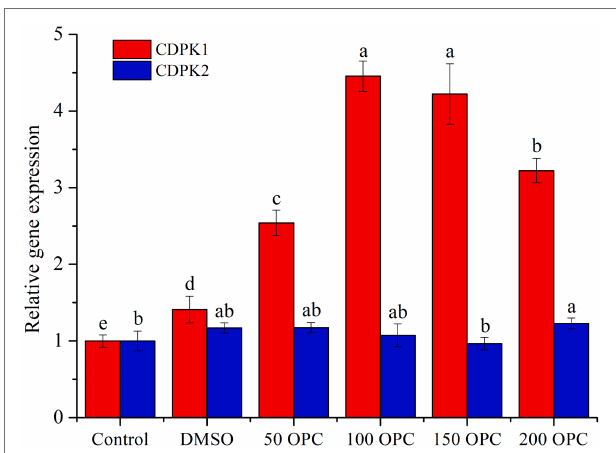
FIGURE 7 | Effect of OPC on the expression level of CDPKs from MG1.